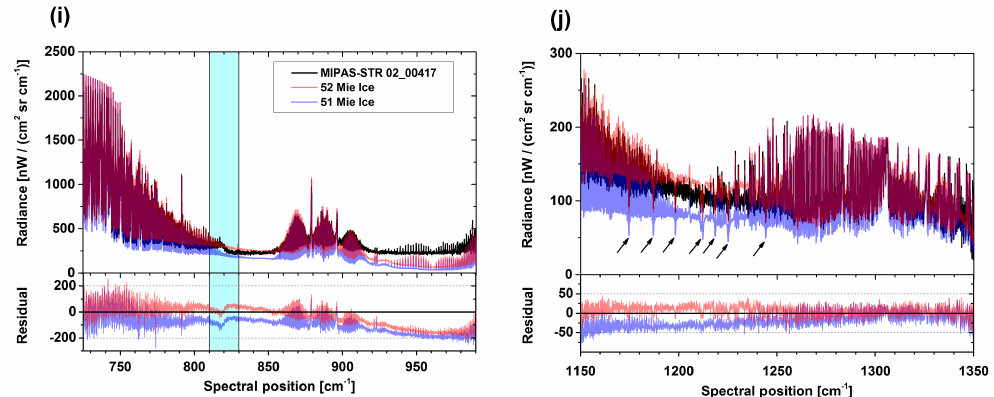
Figure 10. Mie calculations for spherical particles. Black spectra in all panels: MIPAS-STR limb observation (13:47UTC, tangent altitude 18.4km). Simulations of (a, b) β -NAT, (c, d) α -NAT, (e, f) NAD, (g, h) STS, and (i, j) ice with size distributions A (red) and B (blue). Lower panels: residuals between the simulations and the observation. Black arrows denote prominent H 2 O absorption signatures from scattering of tropospheric radiation by PSC particles. Numbers in the legend refer to scenarios in Table 1. “NATcoa” corresponds to β -NAT and “Mie” to Mie simulation (AR =